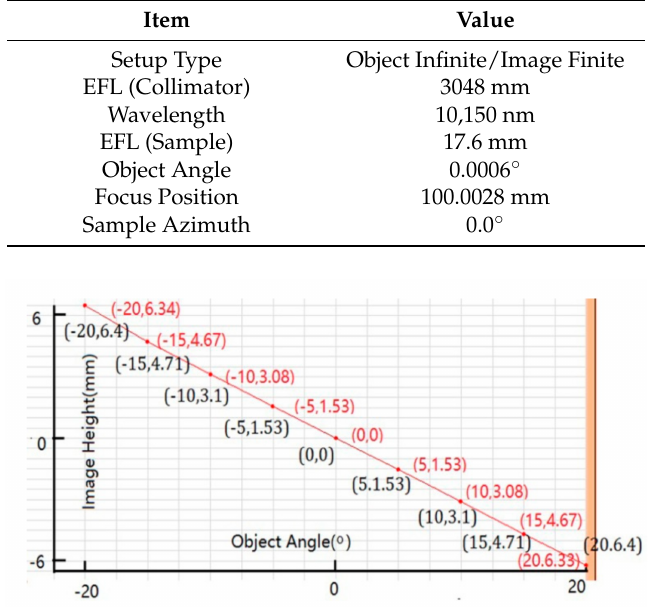
Figure 10. Measurement graph of image height vs. object